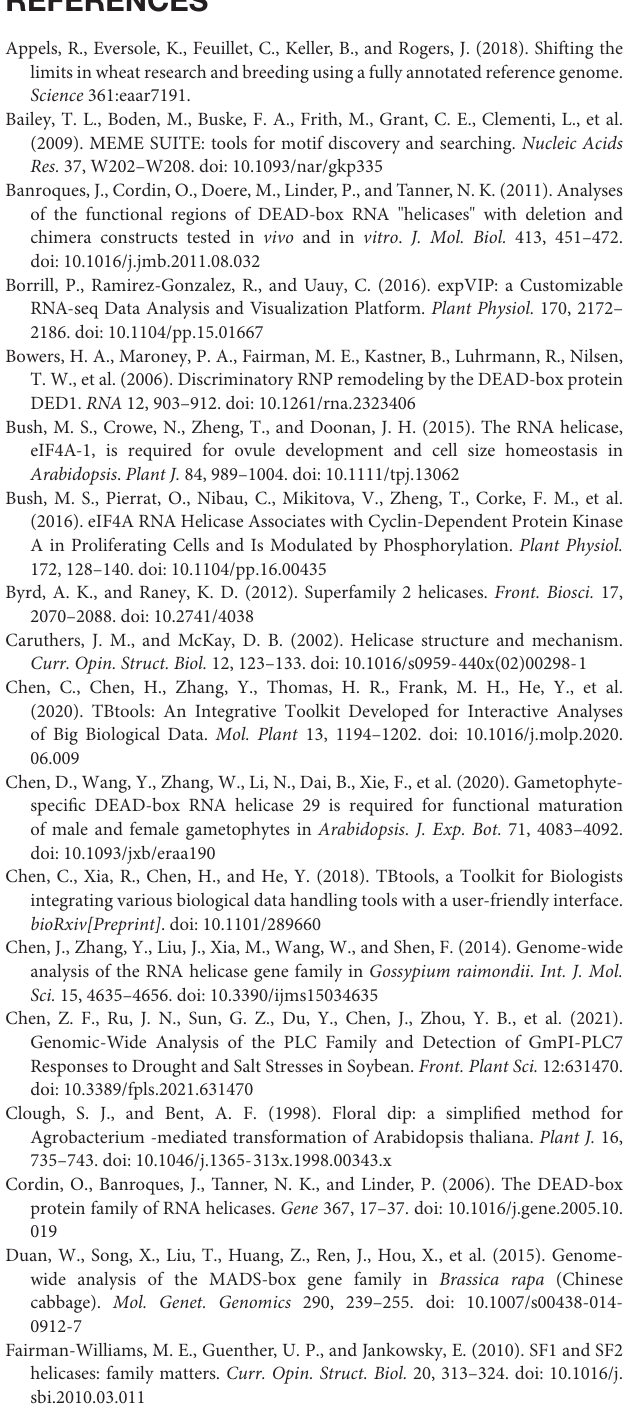
Supplementary Table 3 | Ka, Ks, and Ka/Ks values of duplicated TaDEAD-box genes. Supplementary Table 4 | Exon and intron numbers of 141 TaDEAD-box genes. Supplementary Table 5 | List of conserved motifs in TaDEAD-box proteins.